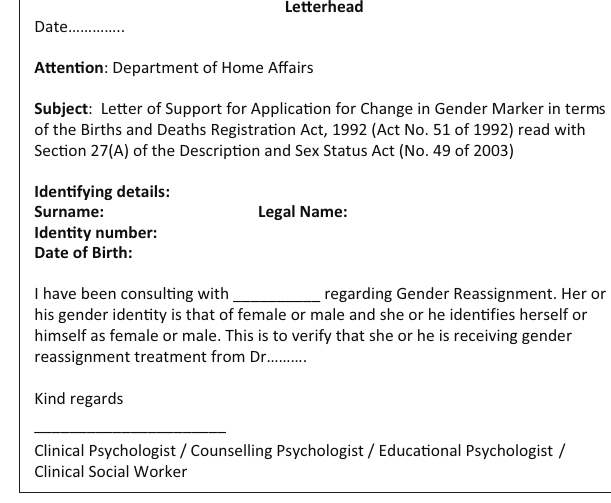
FIGURE 3-A1: Suggested letter in support of application to Department of Home Affairs for change in gender marker – clinical psychologist or counselling psychologist or educational psychologist or clinical social worker.